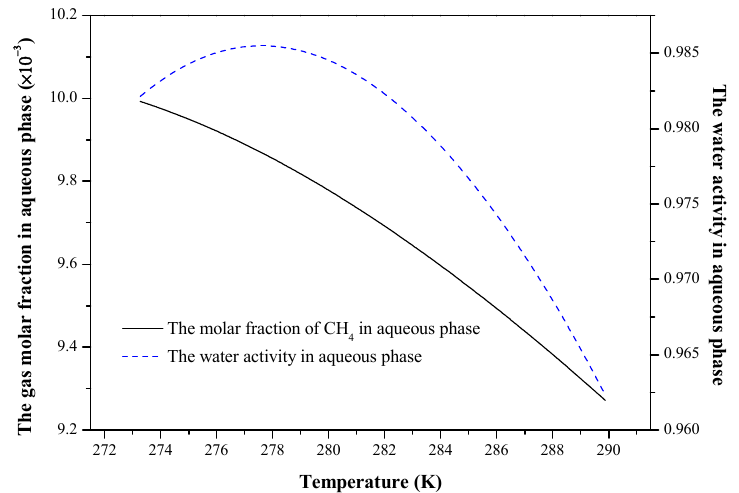
Processes 2019 , 7 , 58 Figure 3. The mole fraction of CH 4 and water activity in aqueous phase. Figure 3. The mole fraction of CH